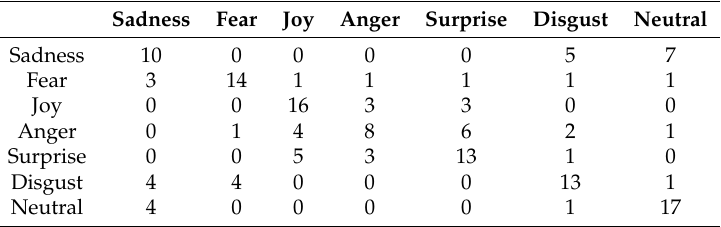
Table A15. P15 actor confusion matrix from the RekEmozio dataset in the second phase.